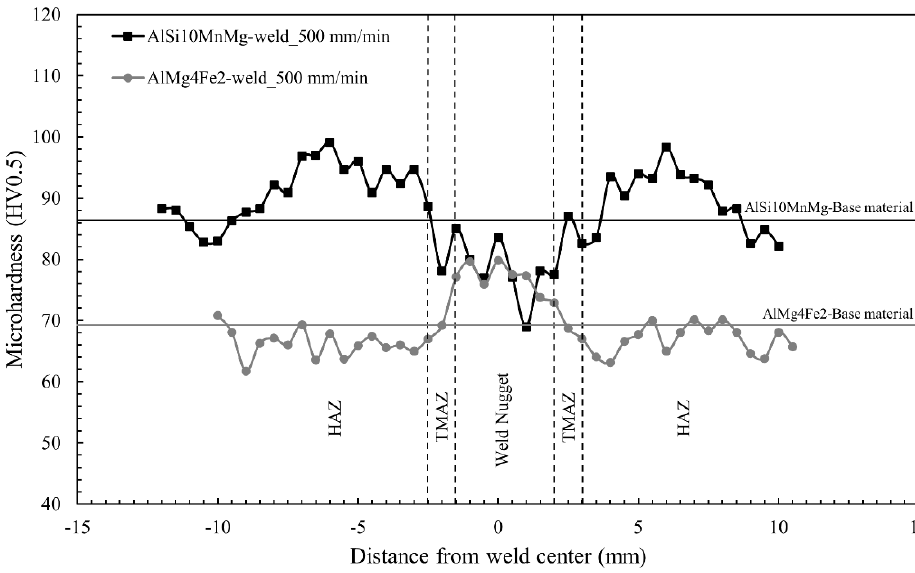
Figure 14. Microhardness profiles for the welds of AlSi10MnMg and AlMg4Fe2 performed at 500 mm/min